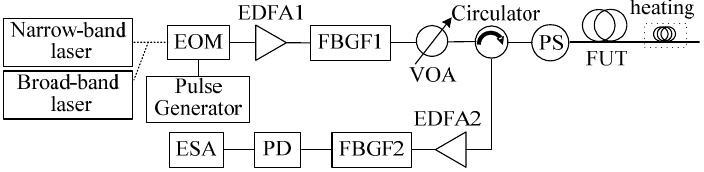
Figure 8. Experimental setup of temperature sensing based on the self-heterodyne detection BOTDR technique.